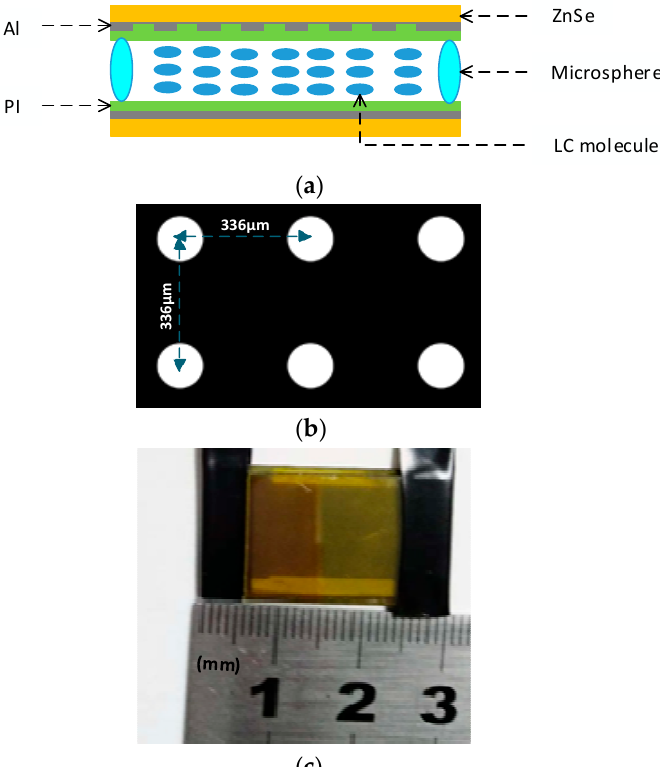
Figure 1. The dual-mode liquid-crystal (LC) micro-device—( a ) main architecture; ( b ) patterned Al electrode; and ( c ) appearance of the final micro-device.